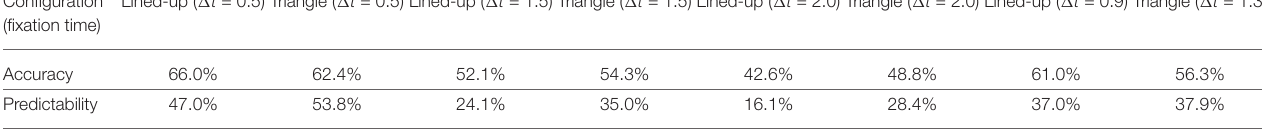
TABLE 3 | Accuracy and predictability of the AoI features considering different fixation times for comparison with the fixation times of 1.5 s used by Shafti et al. (2019) and of 2 s used by Wang et al.